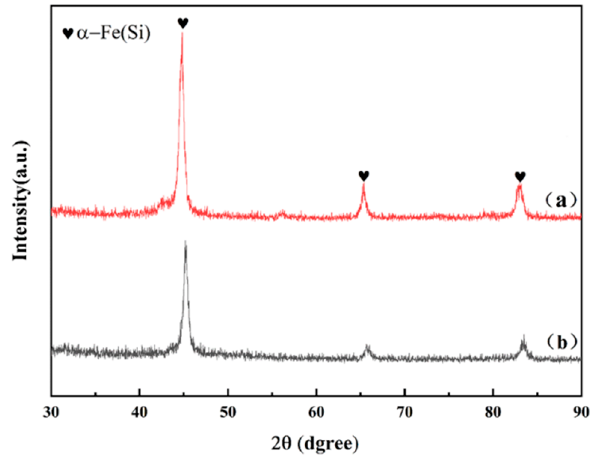
Figure 3. XRD pattern of ( a ) the raw Fe-6.5 wt%Si powders and ( b ) the coated Fe-6.5%Si powders.